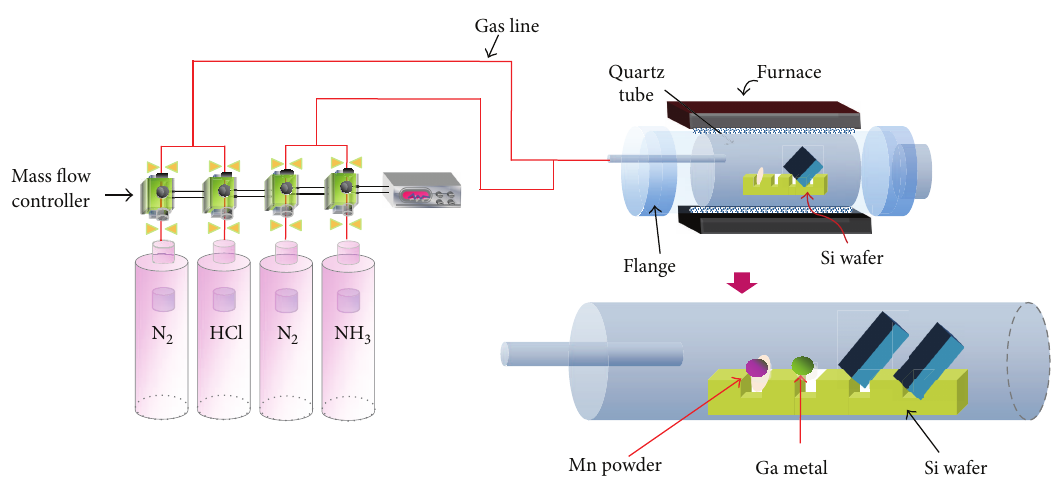
Figure 1: Schematic experimental setup for the growth of GaN and doped Mn.